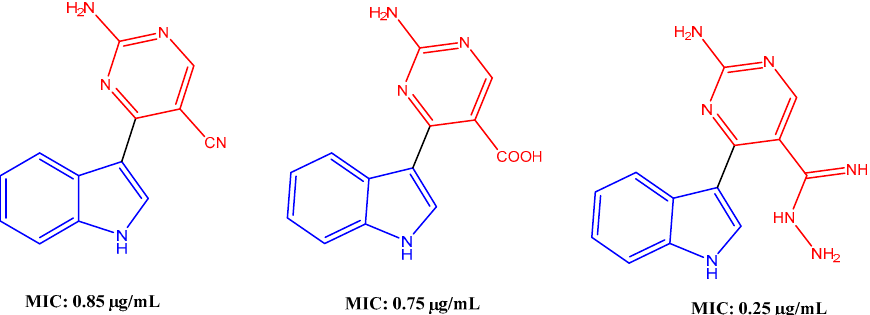
Figure 1. Activity of meridianin D analogs against MCF7.